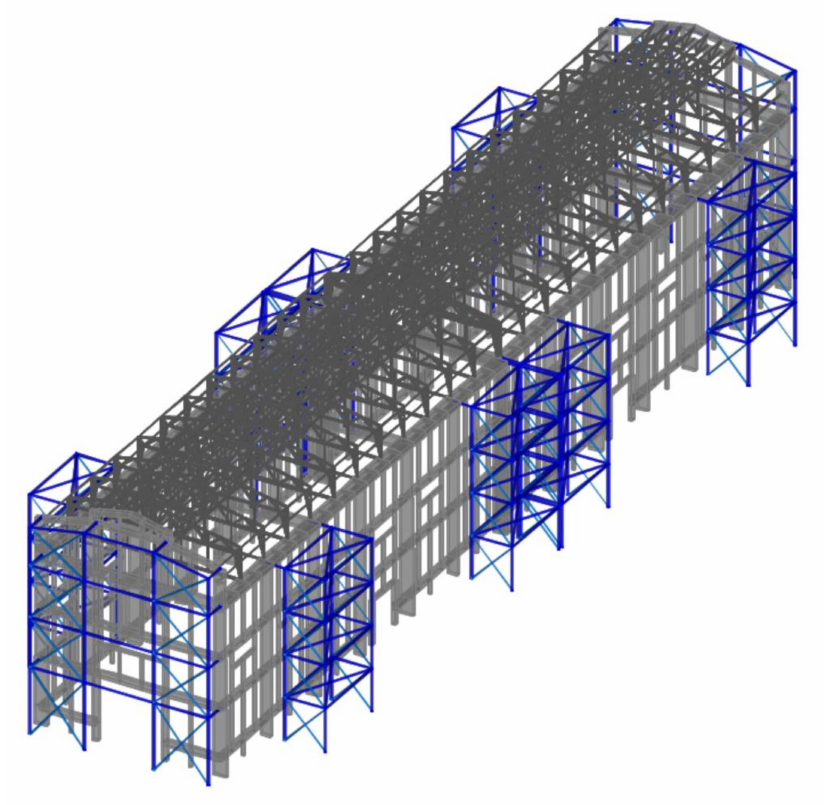
Figure 7. FEM model of the building in the post-intervention